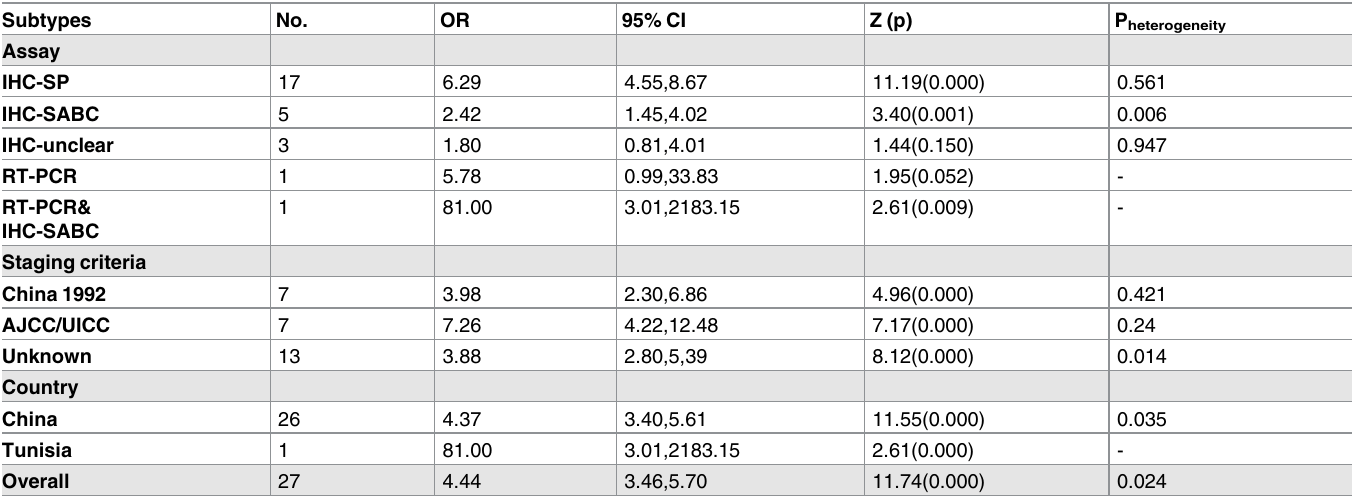
Table 4. Main results from subgroup analyses.